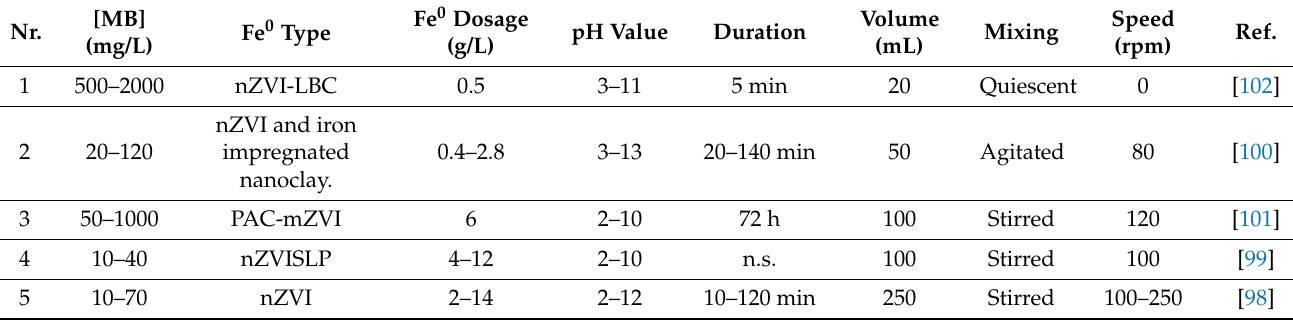
Table 2. Summary of some experimental conditions used for the experiments in the five